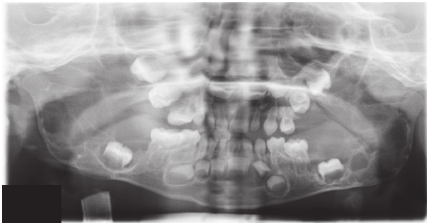
Figure 2: Panoramic radiograph of the